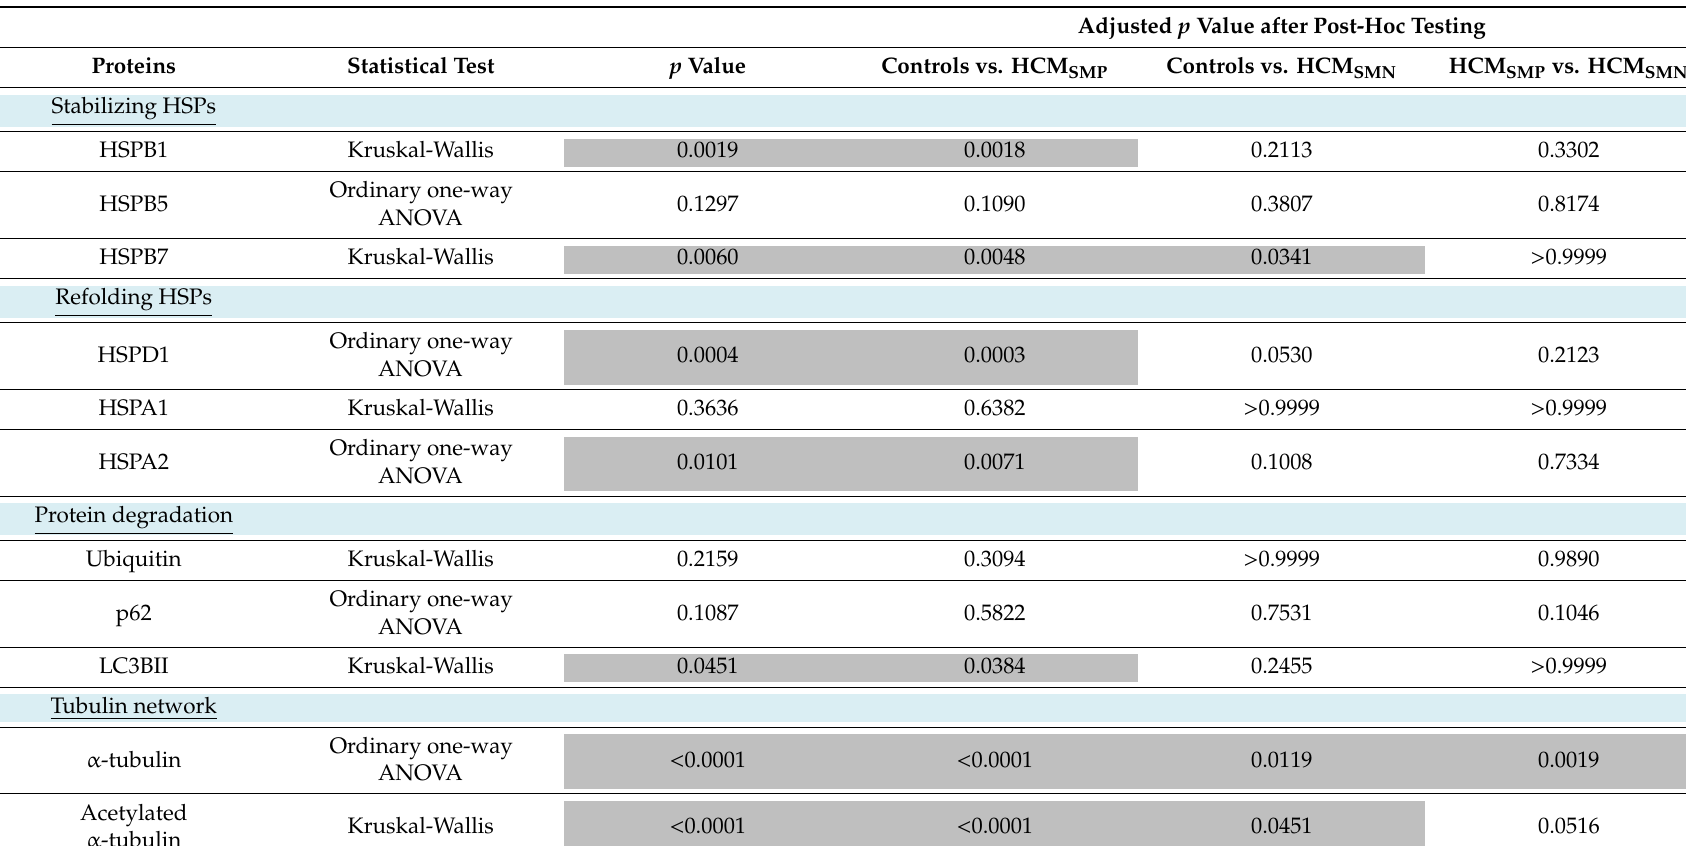
Table 2. Overview of results on statistical testing for di ff erences between controls, HCM SMP and HCM SMN